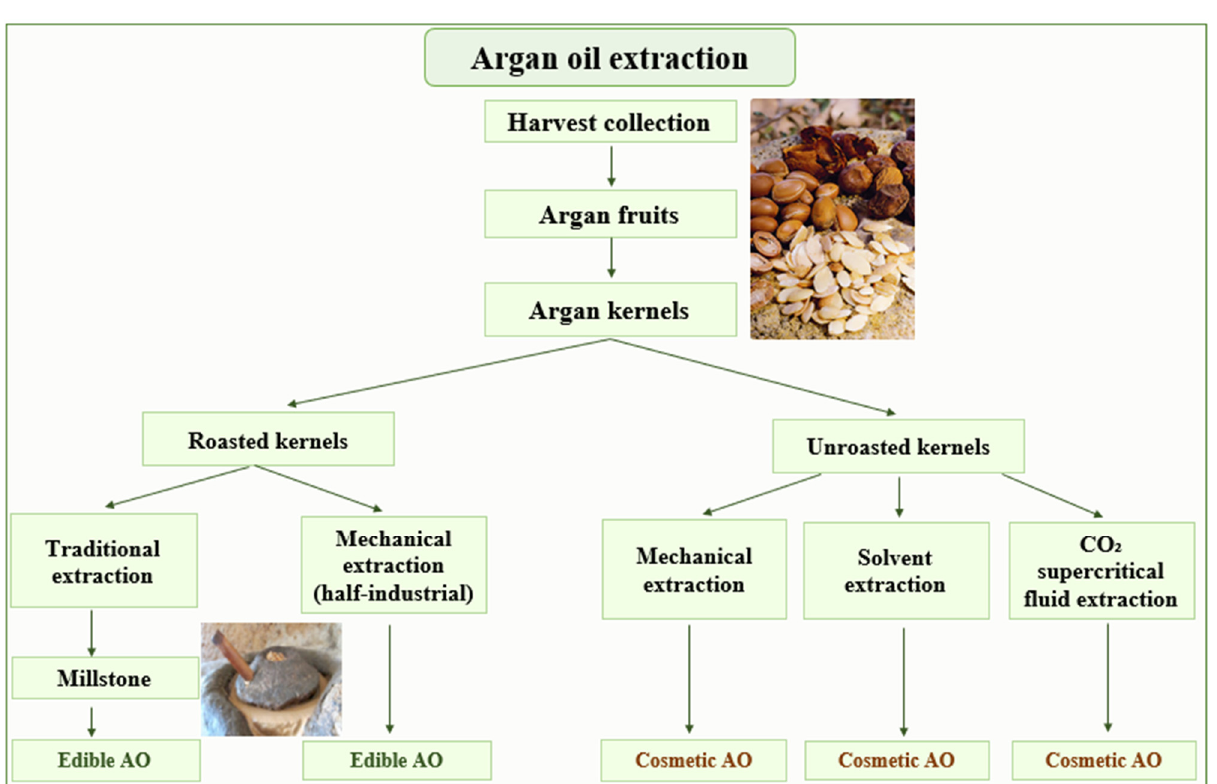
Figure 1. Methods used for Argan oil extraction.